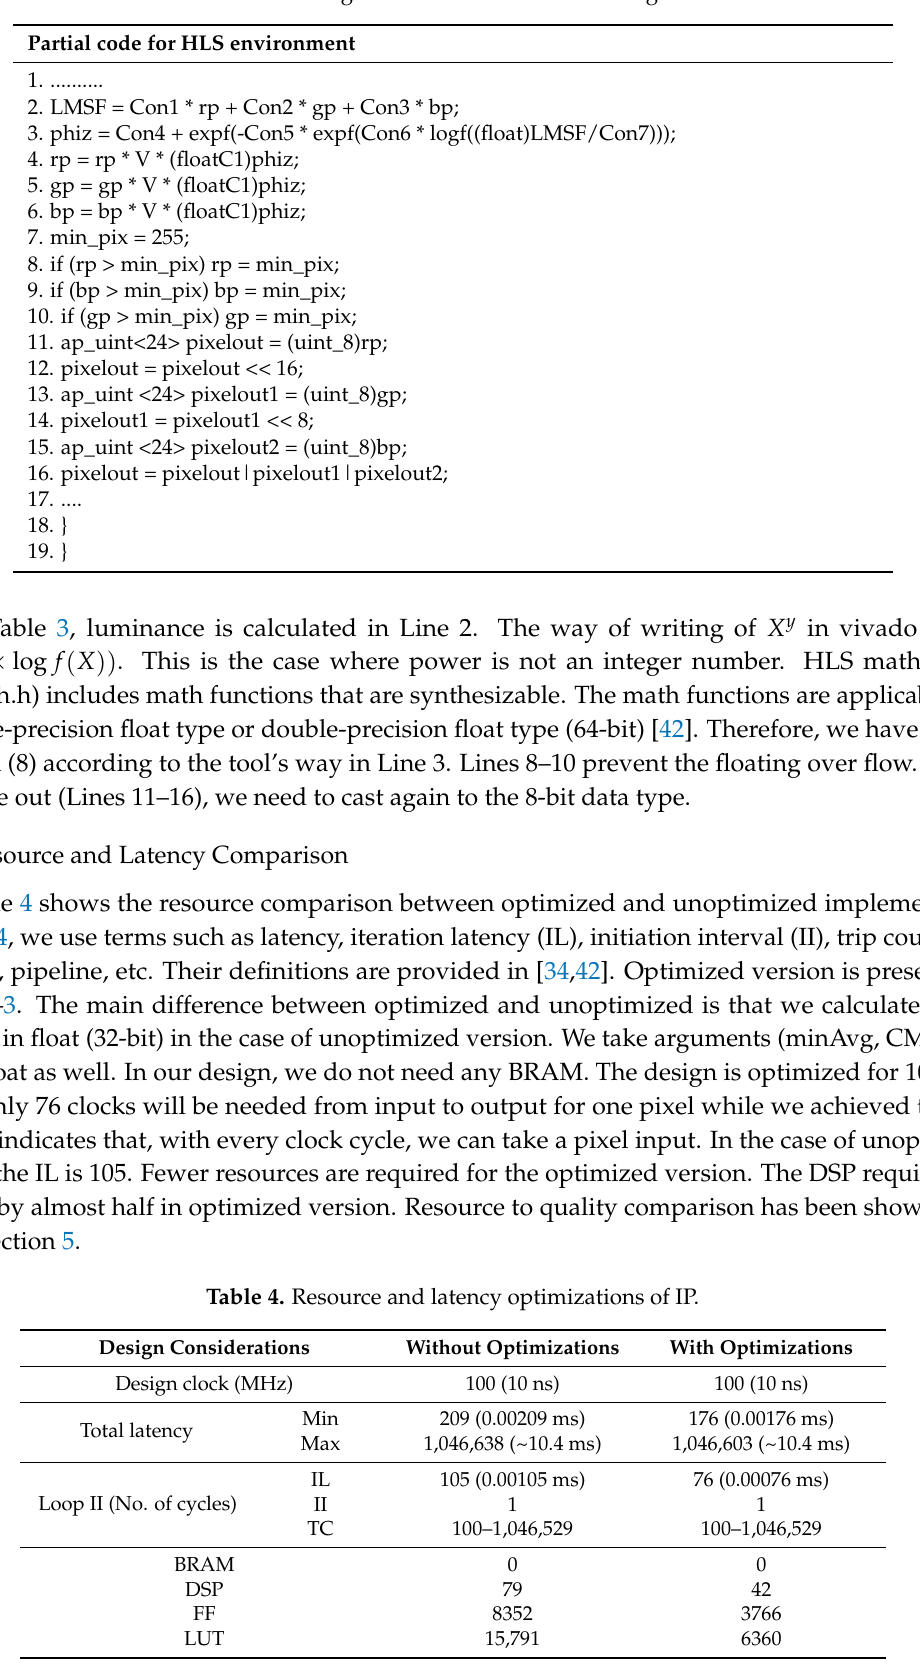
Table 3. Low light area enhancement and image out.